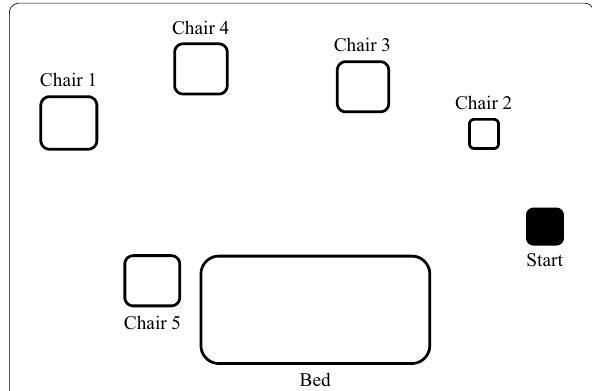
Fig. 9 Overview of the last experiment. Chairs and a bed are put on the experimental area